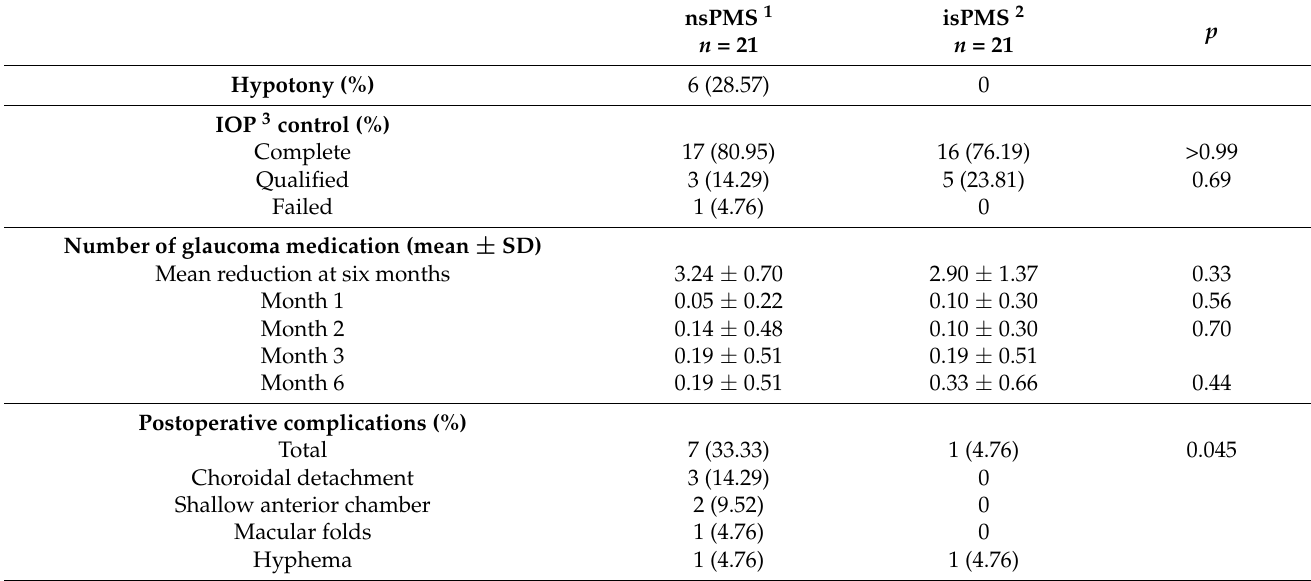
Table 2. Postoperative